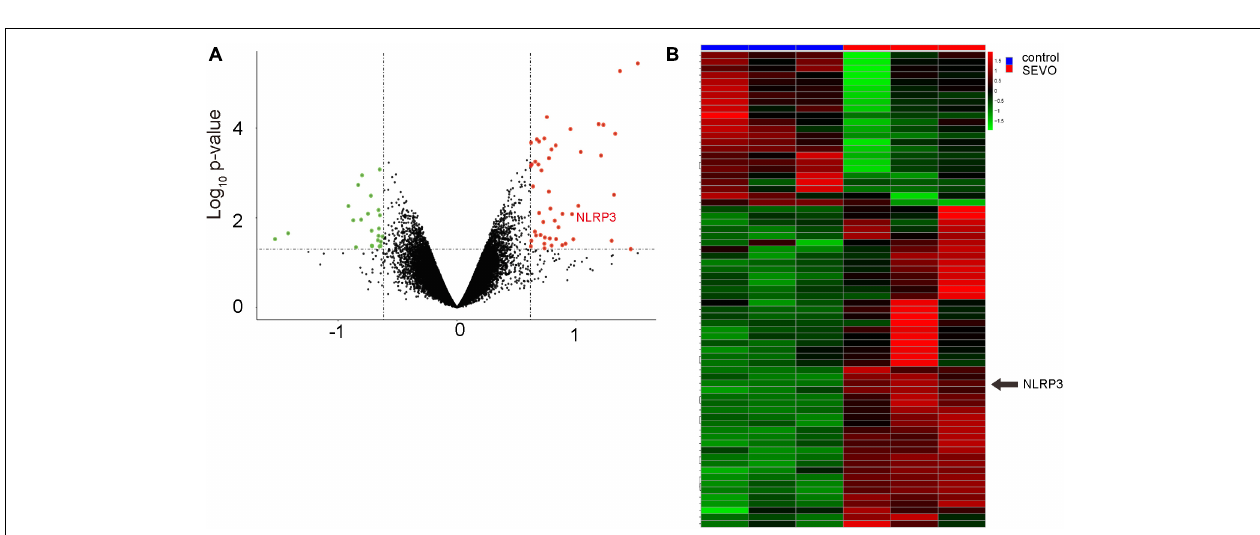
FIGURE 6 | Suppression of NLRP3 increases BDNF in neuronal cells. (A,B) RT-qPCR (A) and Western blot (B) for NLRP3 in neuronal cells from SEVO+MCC mice, compared to those from SEVO mice. (C) Western blot for caspase 1 in neuronal cells from SEVO+MCC mice, compared to those from SEVO mice. (D) ELISA for IL-1 β and IL-18 in neuronal cells from SEVO+MCC mice, compared to those from SEVO mice. (E) Western blot for BDNF in neuronal cells from SEVO+MCC mice, compared to those from MCC mice. * p < 0.05 (SEVO+MCC vs. SEVO). N = 10. N represents mouse number per experimental group.